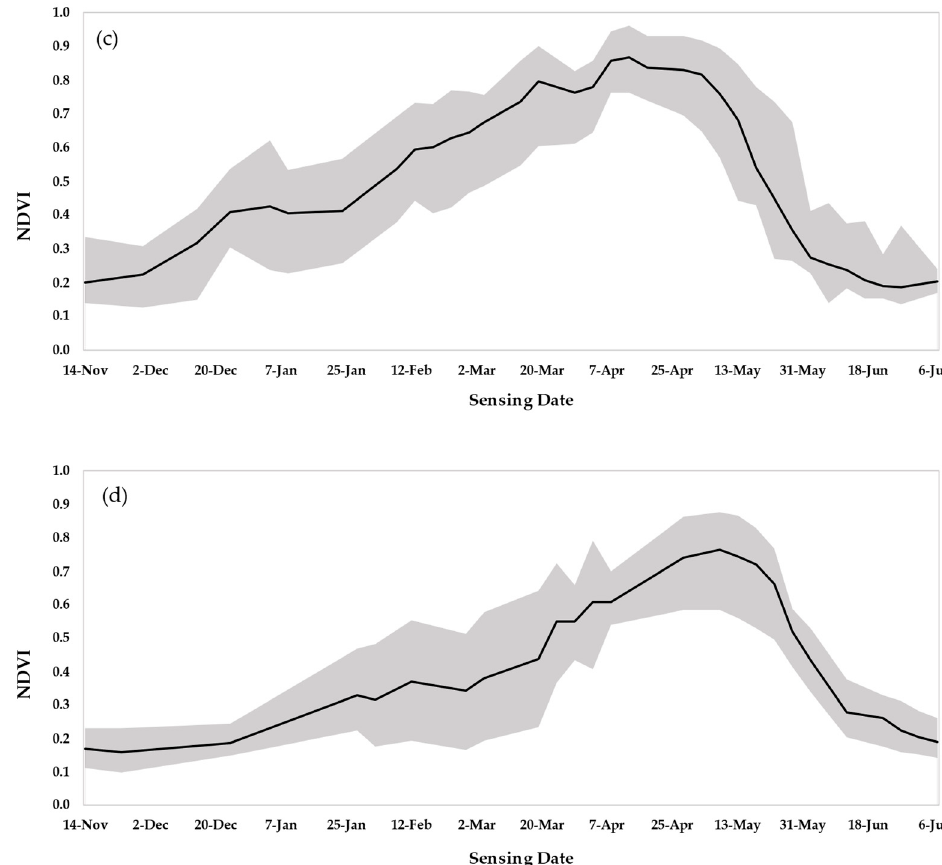
Figure 2. ( a – d ) Reflected phenology, expressed as the NDVI for the 2019/20 and 2020/21 cropping seasons, versus time of the ( a ) high initial growth rate wheat parcels (n = 53), (Larisa region), ( b ) moderate initial growth rate wheat parcels (n = 68) (Larisa region), ( c ) low initial growth rate wheat parcels (n = 41) (Larisa region), ( d ) very low initial growth rate wheat parcels (n = 22) (Kozani region). The black line is the representative–average line of the growth rate.